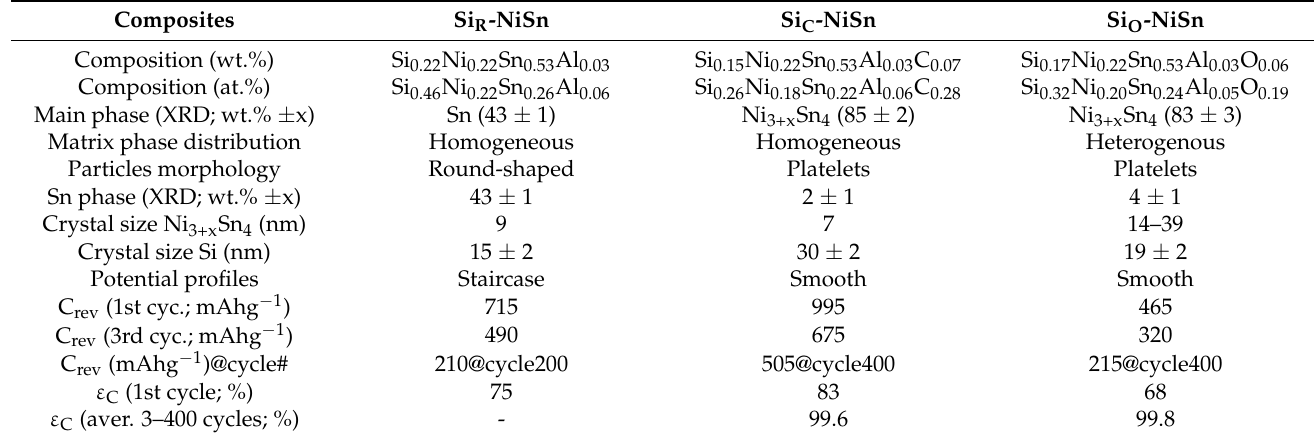
Table 3. Summary of the chemical, microstructural and electrochemical properties of the three composites Si R -NiSn, Si C -NiSn and Si O -NiSn. Composites Si R -NiSn Si C -NiSn Si O -NiSn Composition